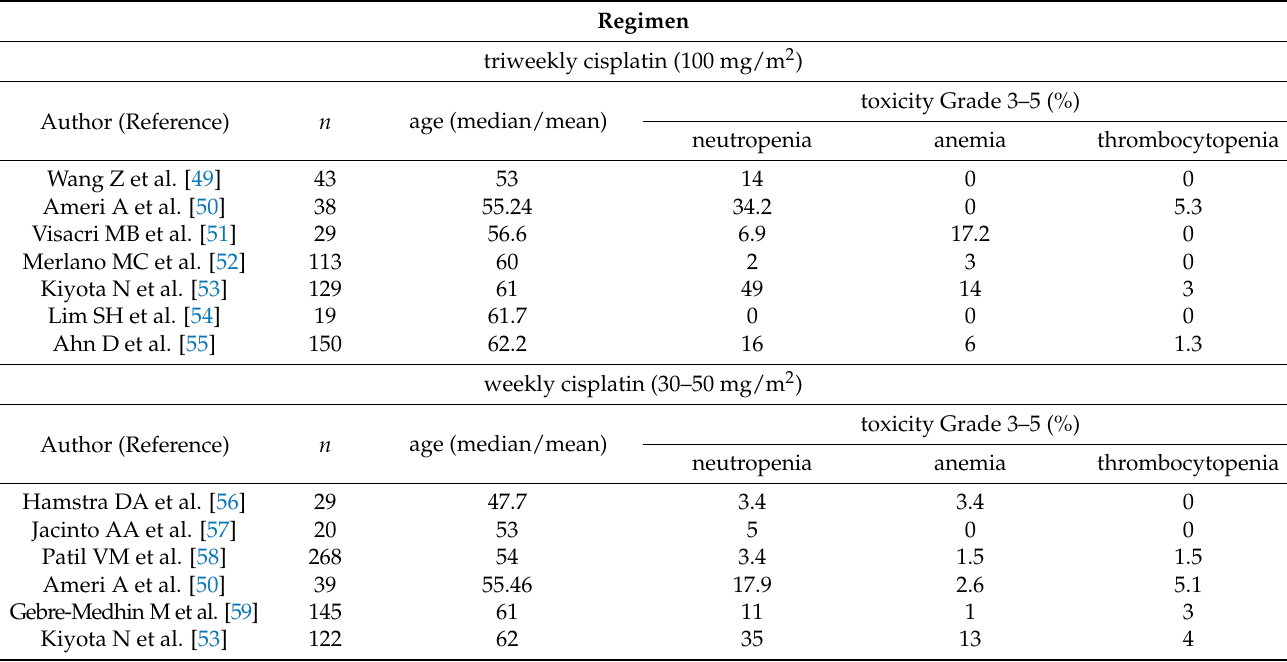
Table 2. The rate of severe myelosuppression in definitive chemoradiotherapy with cisplatin.